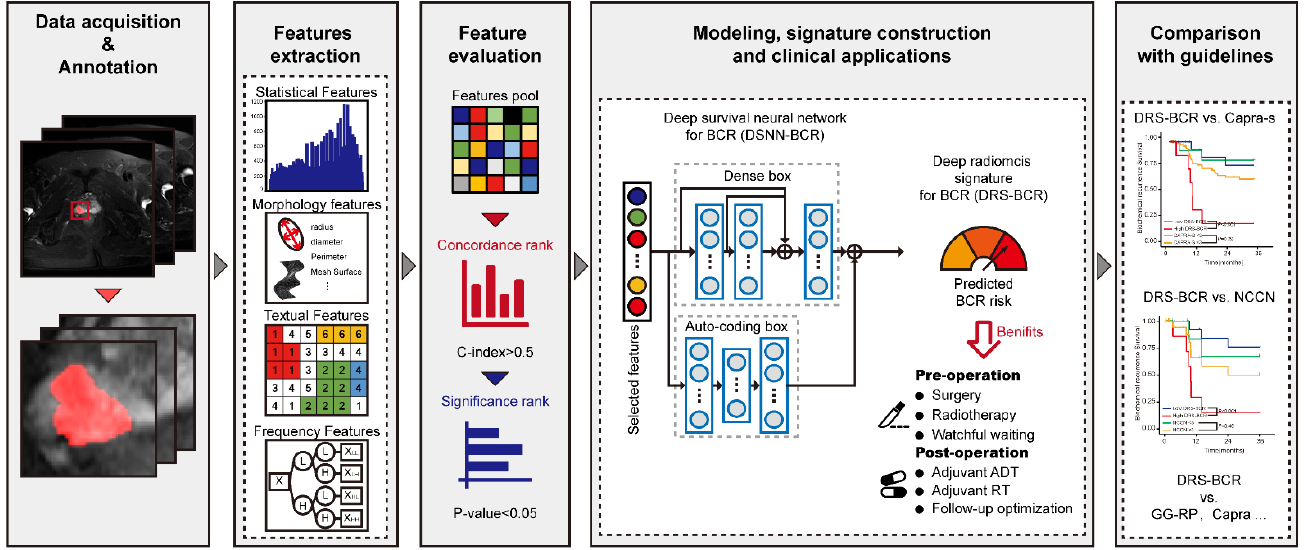
Figure 1. The workflow of radiomics-based model for data preparation, modeling, signature construction, predicting BCR-free survival, and clinical applications. DSNN: deep survival neural network; BCR: biochemical recurrence; DRS: deep radiomic signature; CAPRA: Cancer of Prostate Risk Assessment; NCCN: National Comprehensive Cancer Network; GG: Gleason grade group system.